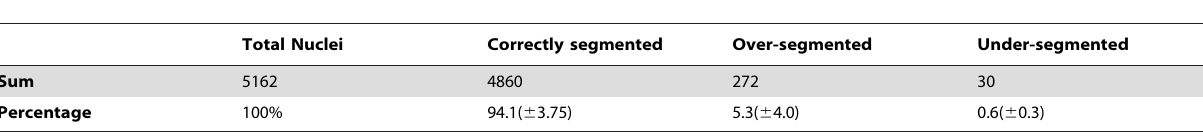
Table 2. Accuracy of the watershed cell